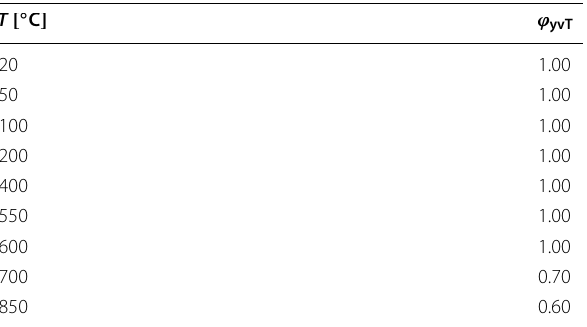
Table 1 The yield strength reduction factor of reinforced steel.